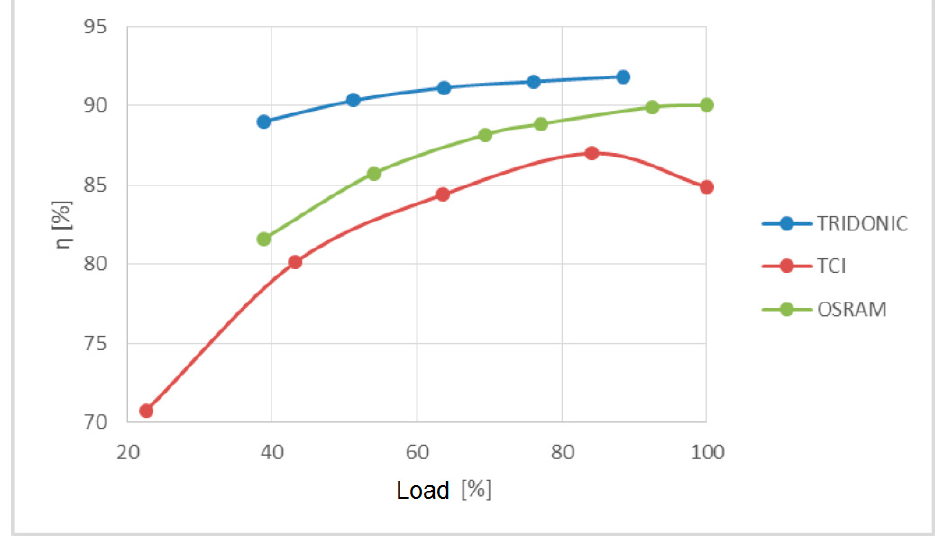
Figure 14. The influence of the power supply load on the efficiency.